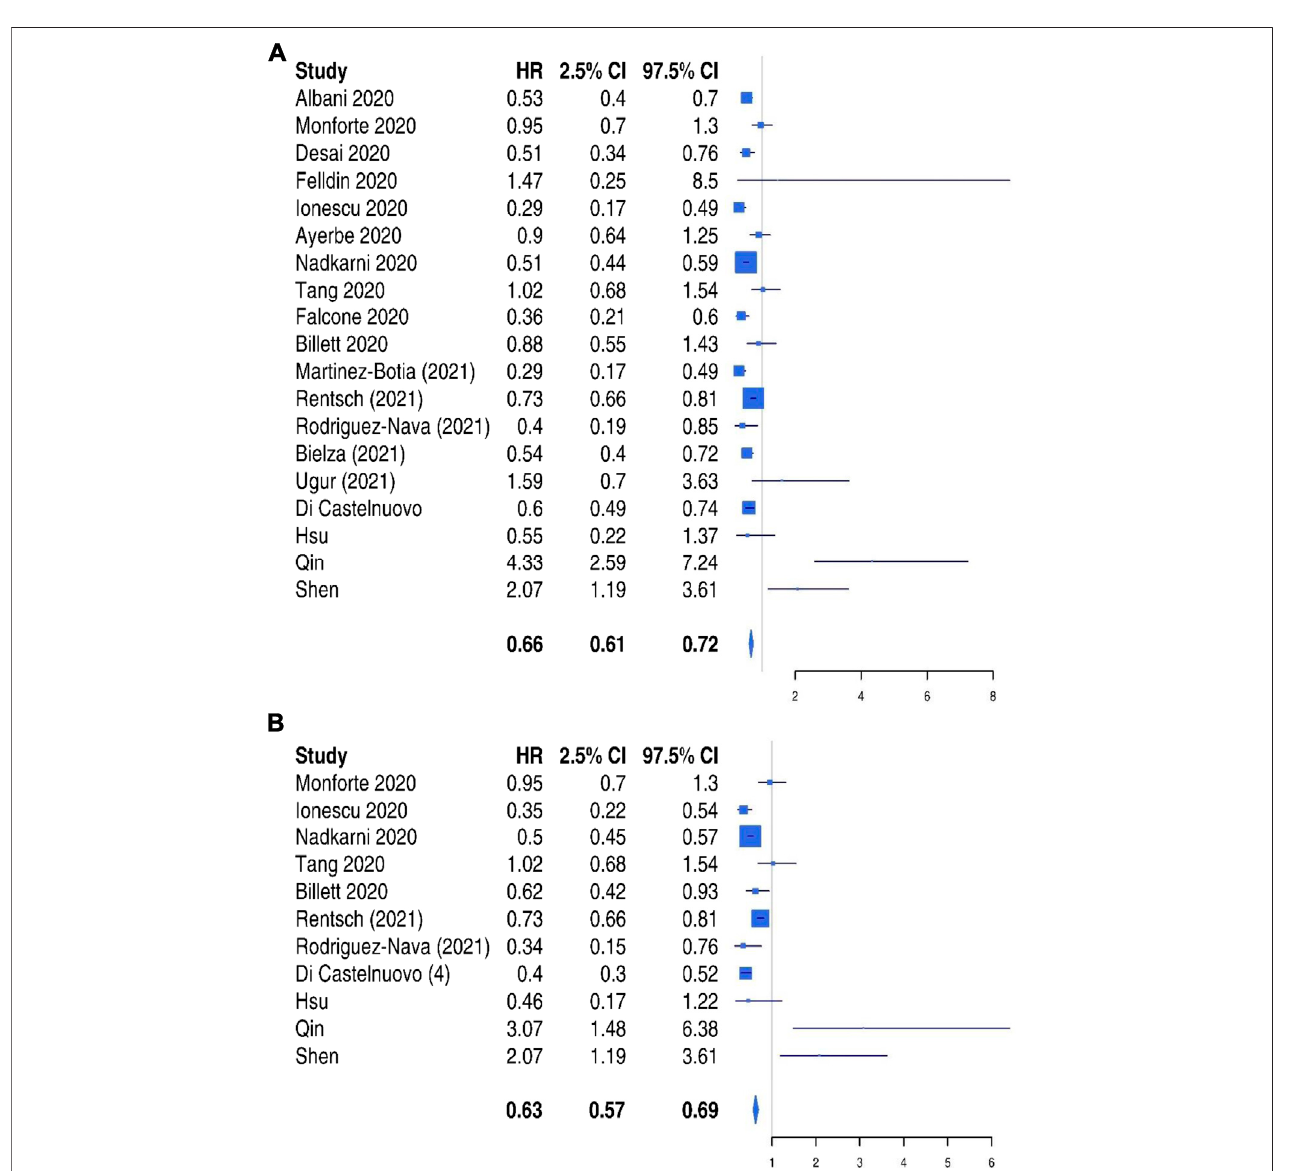
FIGURE3| All-causemortalityriskinpatientstreatedwithheparin:overallanalysis (PanelA) ,prophylacticdose (PanelB), andfulldose (PanelC) comparedtono treatment and comparison between full dose and prophylactic dose (Panel D) .